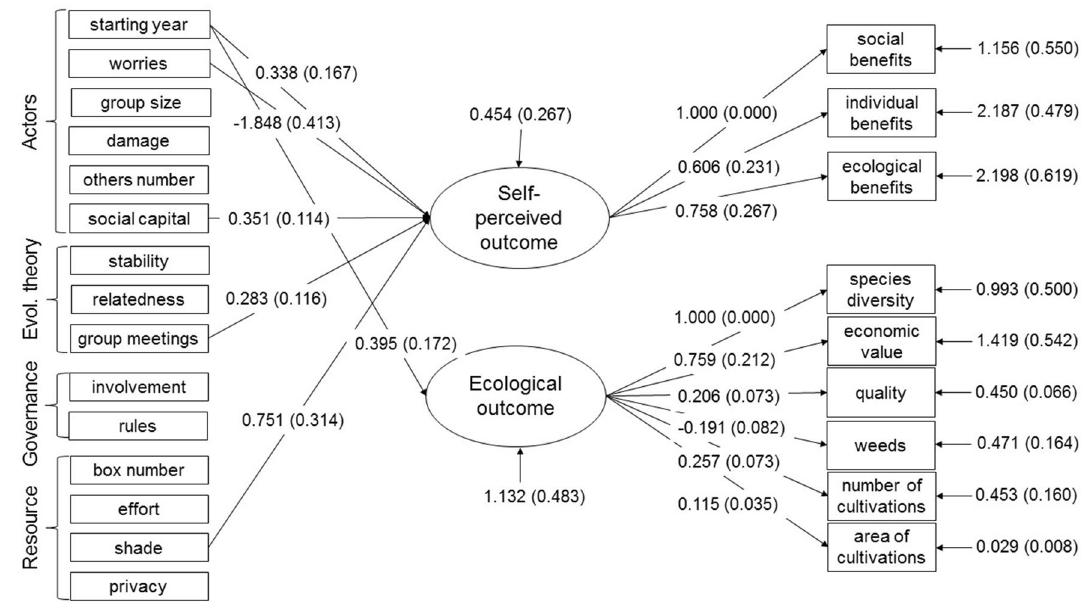
Figure 4. The SEM results for the variables belonging to the sub-systems Actors, Governance, Resource and Evolutionary theory, predicting the two latent variables Self-perceived and Ecological outcomes described by their reflective indicators. The regression coefficients presented by arrows pointing to the latent variables show the significant ( p value < 0.05) associations between the predictors and the outcomes (note that the non-significant predictors were not omitted from the model, see Table 2). The estimates presented are unstandardized estimates and their standard errors are presented in brackets. Error terms signifying the variance not explained by the model are included for latent variables and the reflective